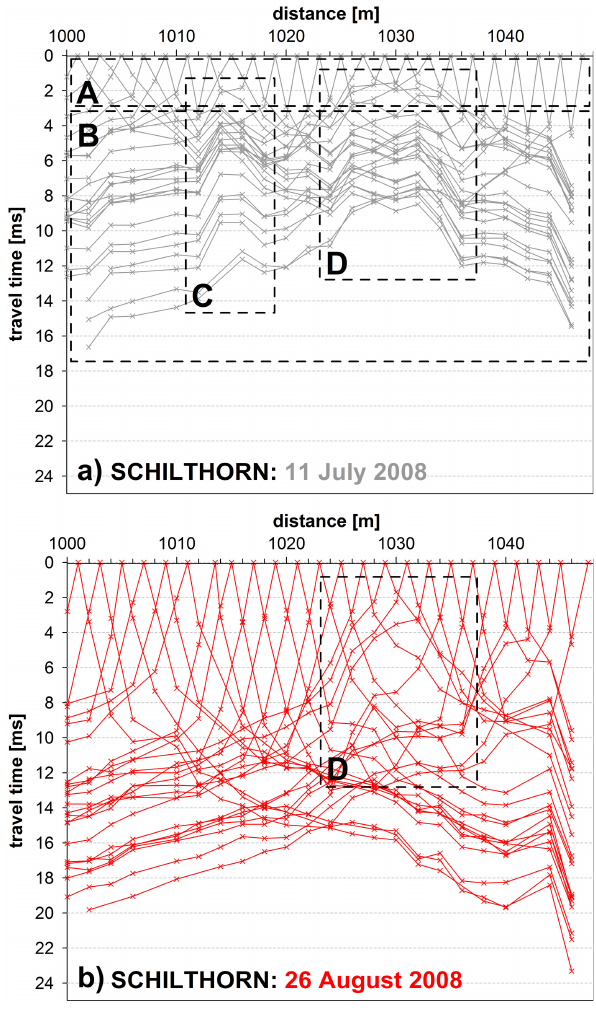
Fig. 6. Combined travel time curves for the measurement at Schilthorn from (a) 11 July 2008 (grey) and (b) 26 August 2008 (red). Zones A to D are described in the text.